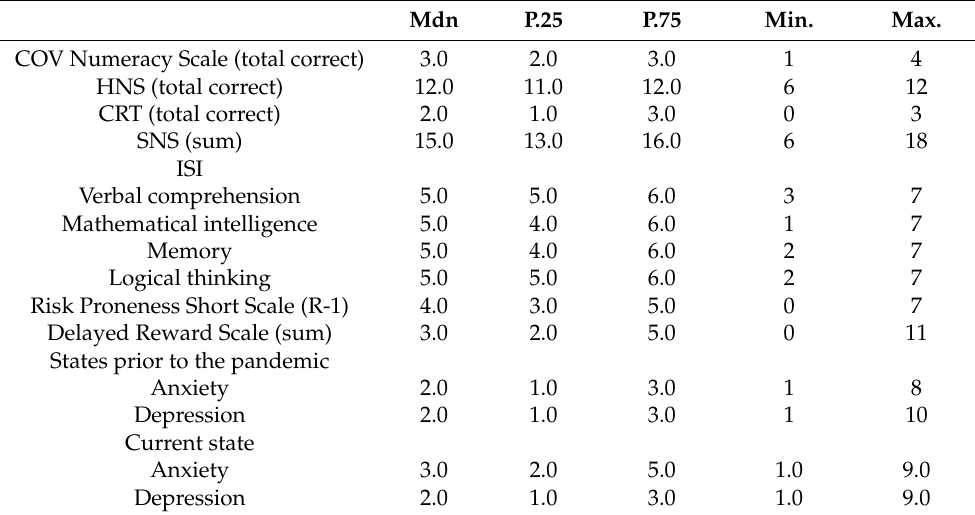
Table 1. Frequencies, medians, interquartile ranges, and minimum/maximum scores in the adminis- tered